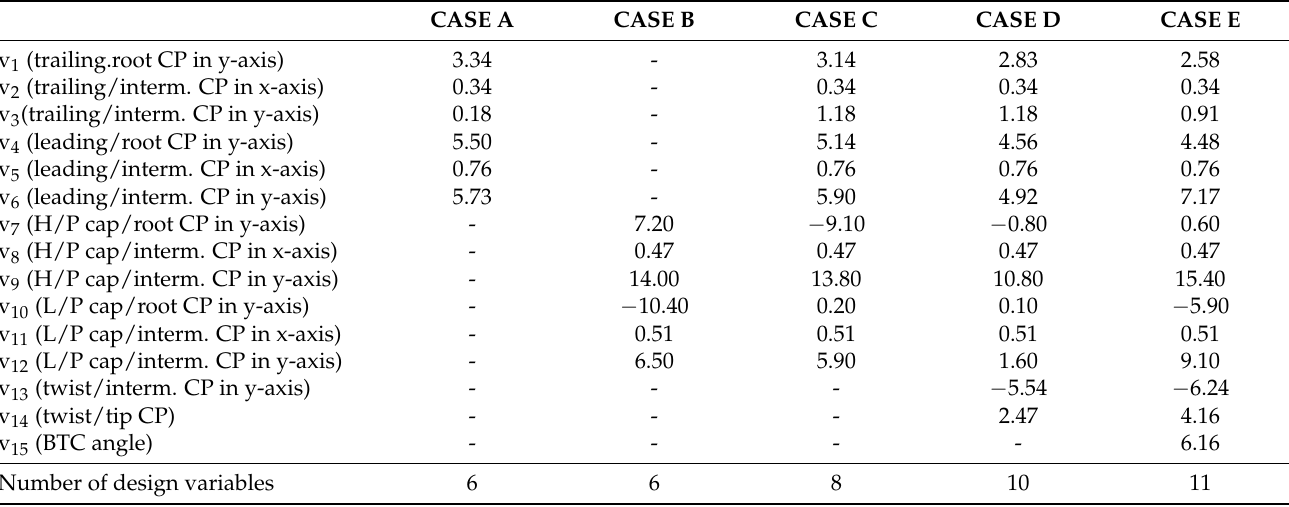
Table 3. Results for the design variables of the considered configurations. Numbers in red correspond to design variable values that remain fixed in the